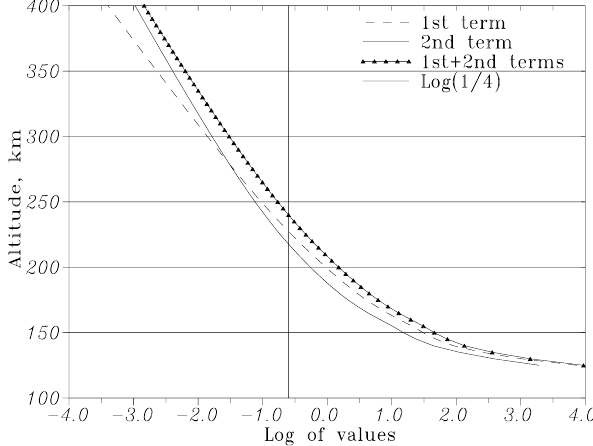
Fig. 6. Calculated N e (h) profiles with a complete set of processes and in a photo-chemical equilibrium for daytime conditions. The observed profile is shown as well.